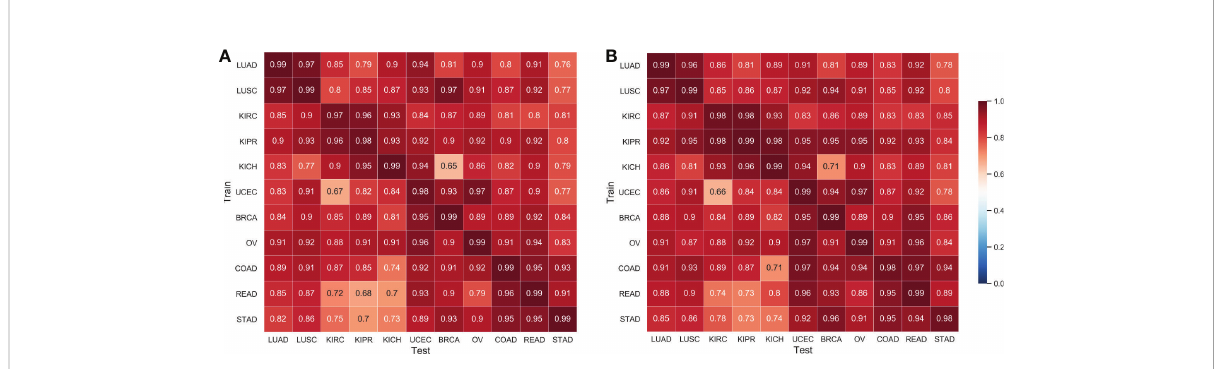
FIGURE 5 AUC of cross-classi fi cations on eleven tissues by the supervised CNN classi fi cation model and the proposed semi-supervised method. (A) Results by the supervised CNN classi fi cation model; (B) Results by the proposed semi-supervised method. The horizontal axis of the heatmap represents the classi fi cation model trained on one set of cancer type data, and the vertical axis represents the AUC performance of the test data on the corresponding training